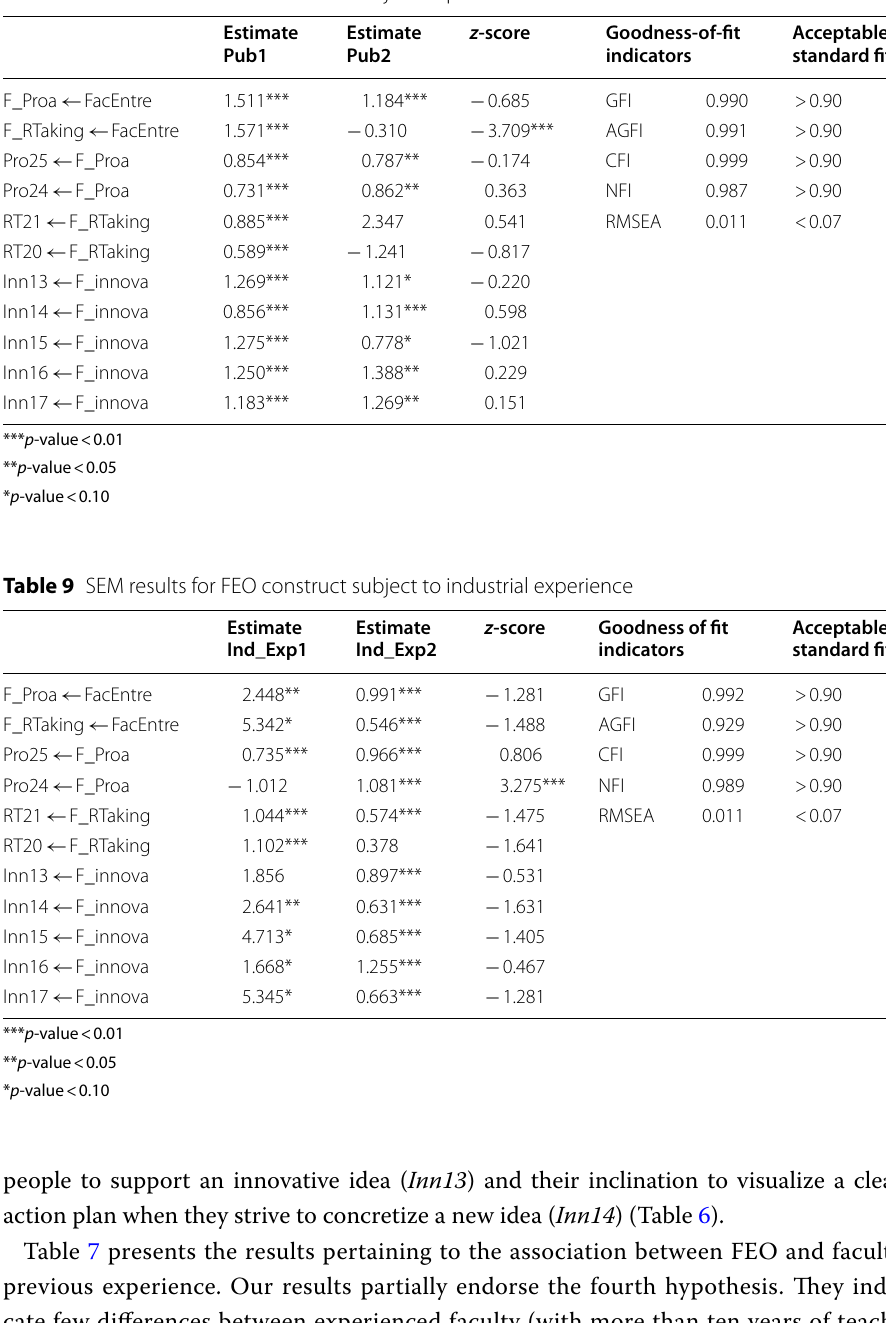
Table 8 SEM results for FEO construct subject to publication